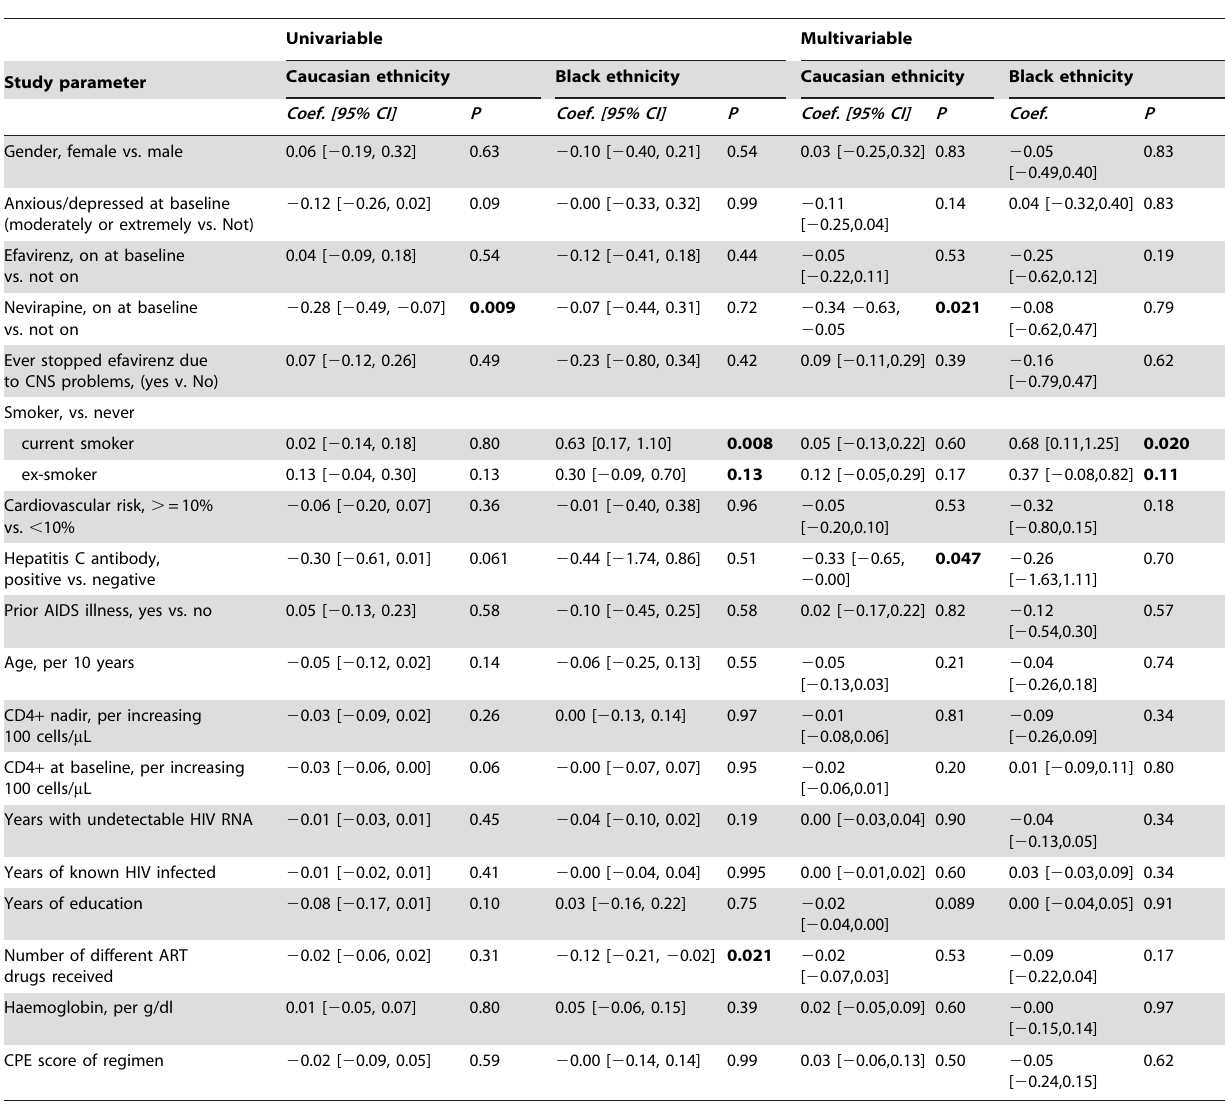
Table 3 legend : CI = confidence interval; CPE = Clinical Penetration Effectiveness; NPZ-5=mean neuropsychiatric z-score for 5 domains; Coef =regression coefficient. P values ( P ) , 0.05 shown in bold. " Overall p-value for smoking in subjects of Black ethnicity 0.016 (univariable) and 0.022 (multivariable).